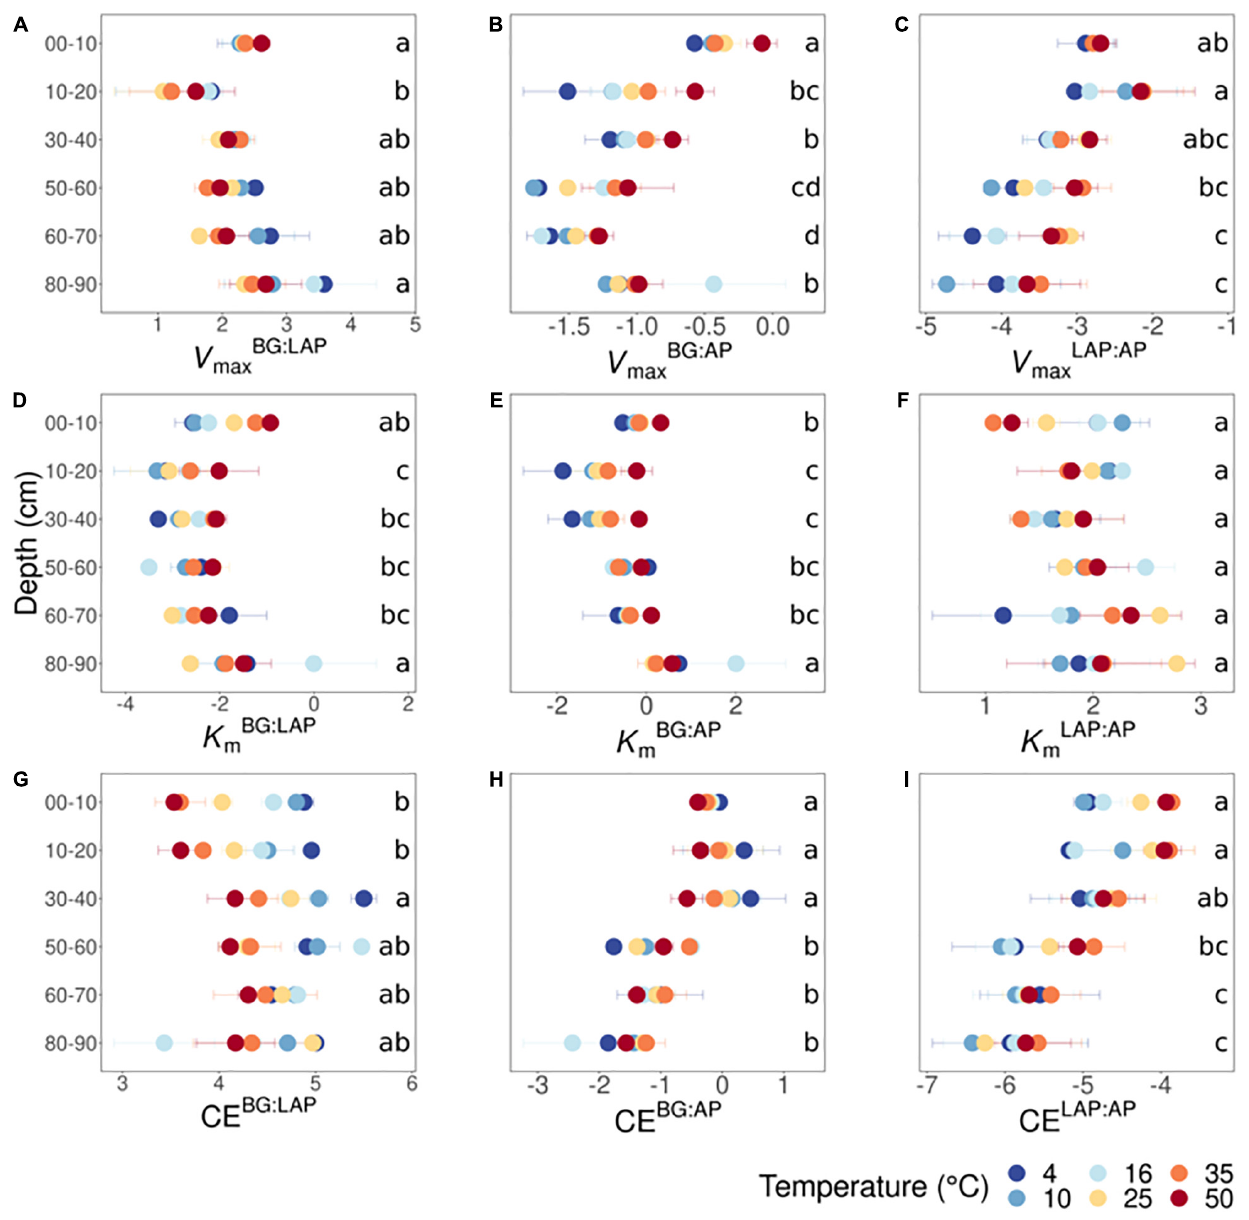
FIGURE 4 | Ratios between kinetic parameters of BG, LAP and AP at different depths and six temperatures from 4 to 50 ◦ C. (A) V maxBG : LAP , (B) V maxBG : AP , (C) V maxLAP : AP , (D) K mBG : LAP , (E) K mBG : AP , (F) K mLAP : AP , (G) CE BG : LAP , (H) CE BG : AP , and (I) CE LAP : AP . Two-way ANOVA with depth and temperature as interactive factors indicated that depth had a significant effect on all ratios ( p < 0.05), except on K mLAP : AP , whereas temperature had a significant effect only on V maxBG : AP , V maxLAP : AP and CE BG : LAP ( Supplementary Table 5 ). There was a depth × temperature effect only on CE BG : LAP . Colors indicate incubation temperatures and letters indicate significant differences ( p < 0.05) between depths per ratio, based on Tukey’s tests after ANOVA tests. Error bars represent the standard error of the mean ( n = 3); dots without error bars represent data-points with n < 3 (data excluded due to Michaelis-Menten models with poor